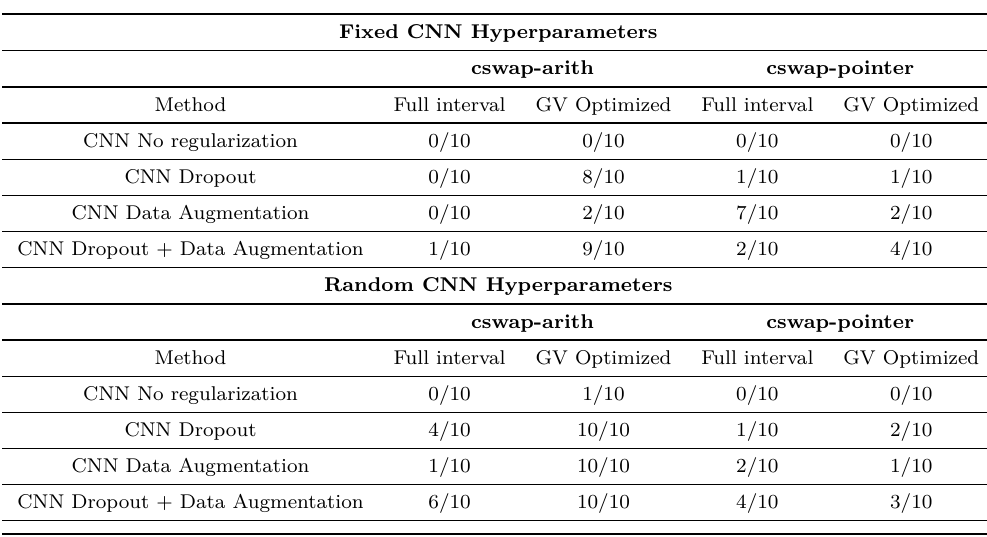
Table 4: Summary of ten iterative framework executions: number of cases where the framework achieves 100% of maximum single trace test accuracy, for fixed and random CNN hyperparameters. Results are provided for full sample intervals and after selecting an optimal interval gradient visualization (GV) results.